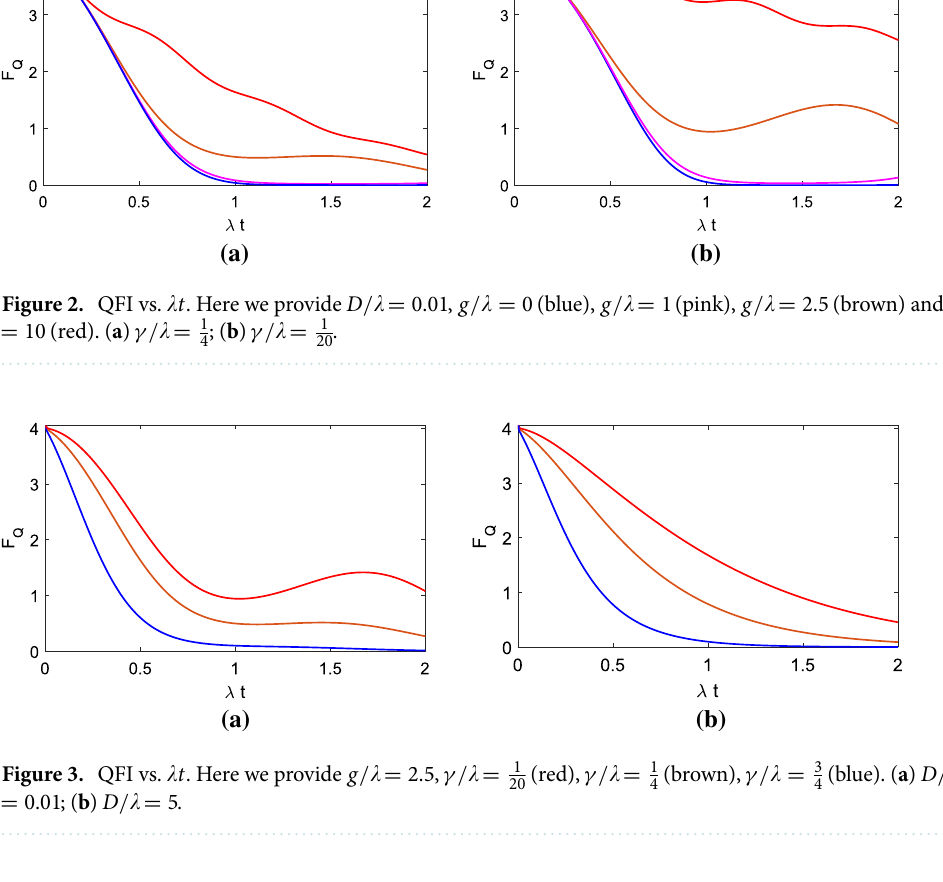
Figure 3. QFI vs. (cid:31) t . Here we provide g / (cid:31) = 2.5 , γ/ (cid:31) = = 0.01 ; ( b ) D / (cid:31) = 5